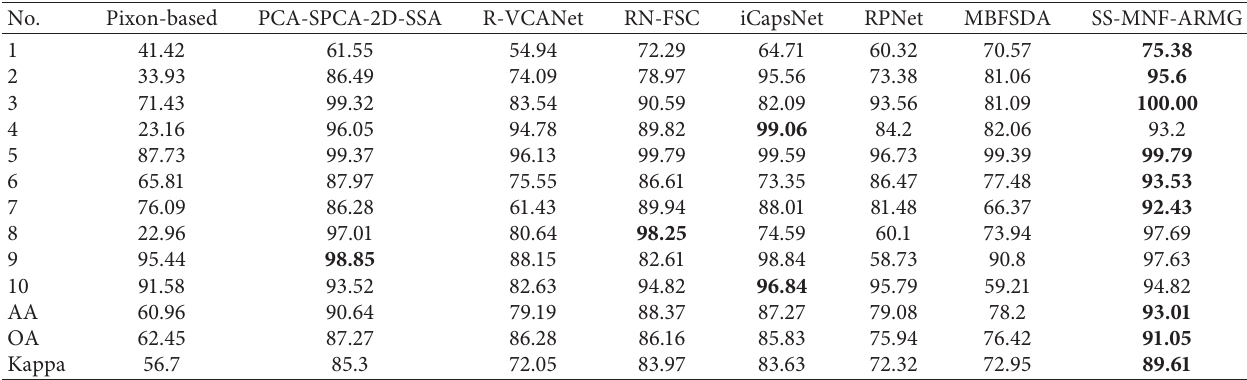
Table 5: Classification results of different techniques for the Indian Pines dataset (10